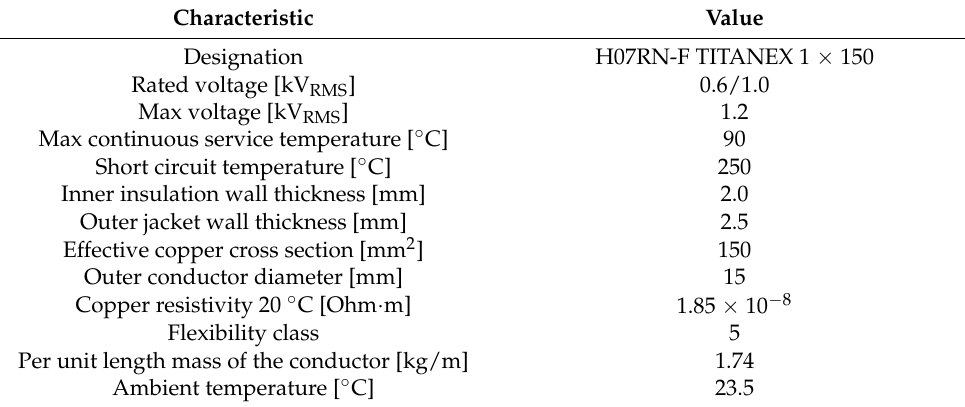
Table 3. Dimensions and characteristics of the second